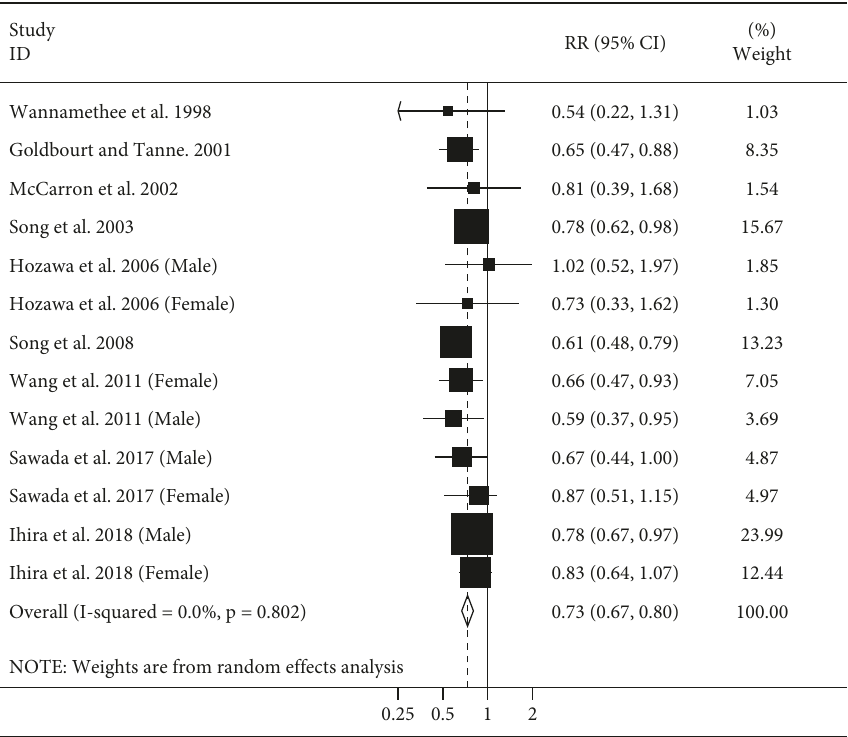
Figure 4: Forest plot for the association between adult height and stroke mortality by considering the highest and lowest height. Horizontal lines represent 95% CIs. Diamonds represent the pooled estimates from the random-effects analysis. RR: relative risk; CI: confidence